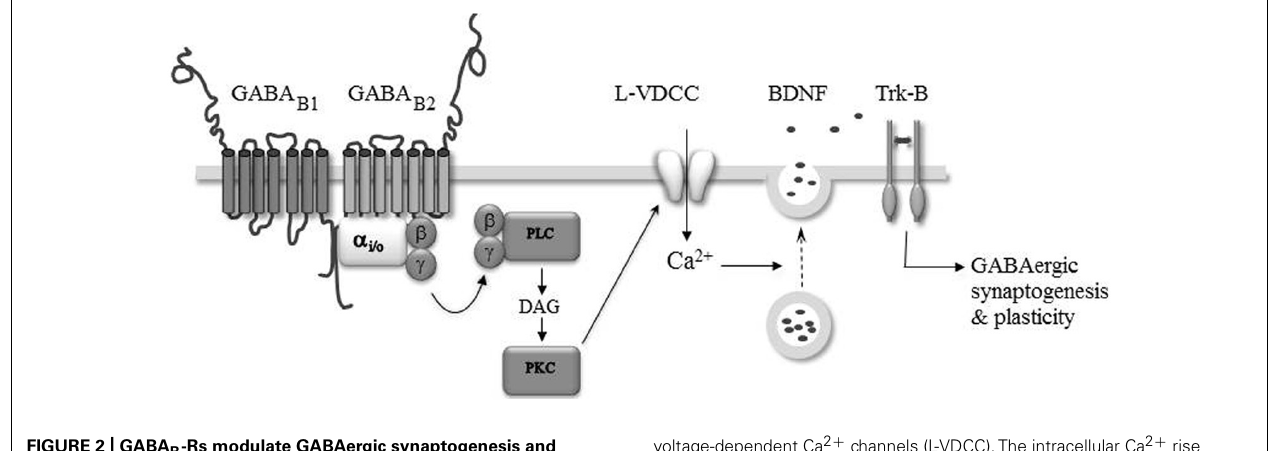
voltage-dependent Ca 2 + channels (L-VDCC).The intracellular Ca 2 + rise triggers the secretion of BDNF which acting onTrkB-Rs modulate the formation and efficacy of developing GABAergic